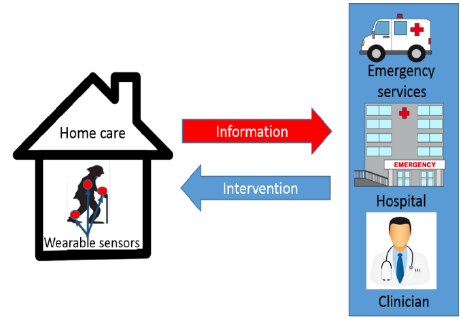
Figure 1. Remote health monitoring architecture based on wearable sensors.